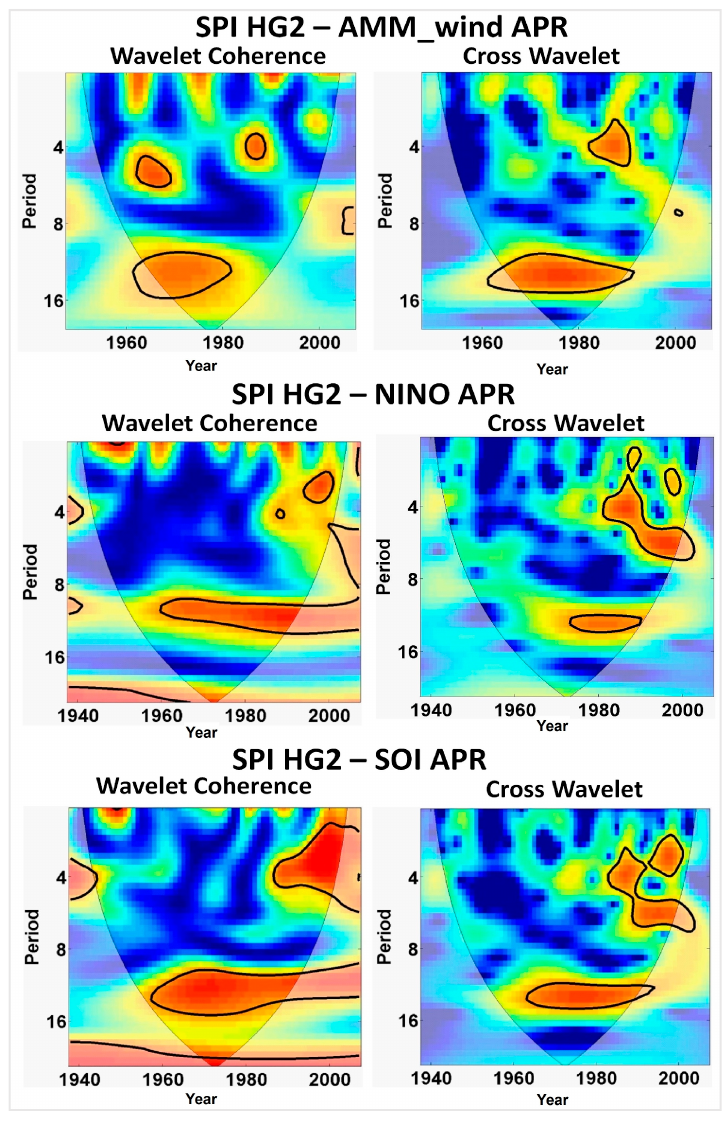
Figure 6. Same as Figure 5 for HG2.